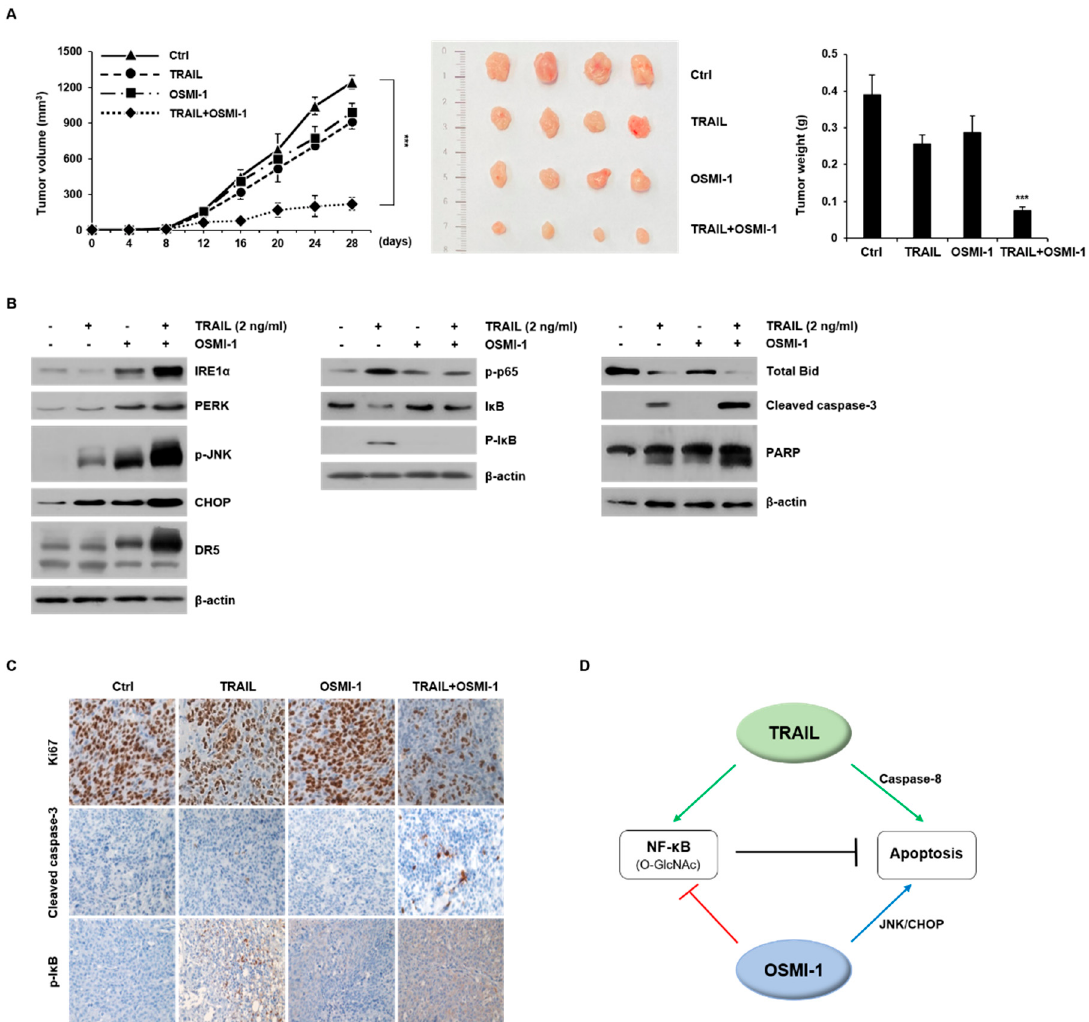
Figure 6. Synergic anticancer activity of combination treatment on HCT116 xenograft in nude mice. (A) HCT116 cells were subcutaneously inoculated in nude mice and tumor growth was monitored for 28 days. Mice were randomized into four groups. Vehicle (DMSO), TRAIL (500 µ g/kg) and OSMI-1 (1 mg/kg) alone or in combination, were administrated using IV injections once every day for 3 weeks. Tumor volumes (mm 3 ) were measured at the indicated time points and growth profiles are shown in the left panel. Data are shown as the mean ± SEM from three independent experiments. *** p < 0.005 compared with the control group. Representative images of the excised tumors derived from nude mice are shown in the middle panel. The graph on the right is the result of measuring the tumor weight at the endpoint. ( B ) Expression levels of proteins related to ER stress response (left panel), NF- κ B signaling (middle panel) and apoptosis (right panel) were determined via western blot analysis using equivalent amounts of total tissue protein. (C) HCT116 tumors from xenograft mice were sectioned for immunohistochemical analysis using antibodies against Ki67, cleaved caspase-3 and p-I κ B (magnification, x200). ( D ) Proposed signaling pathways for anticancer activity following combination treatment with TRAIL and OSMI-1. TRAIL signaling involves not only apoptosis through caspase activation but also cell growth through NF- κ B. OSMI-1 blocks NF- κ B signaling but activates apoptosis through ER stress activation. Arrows and bars represent activation and suppression, respectively.